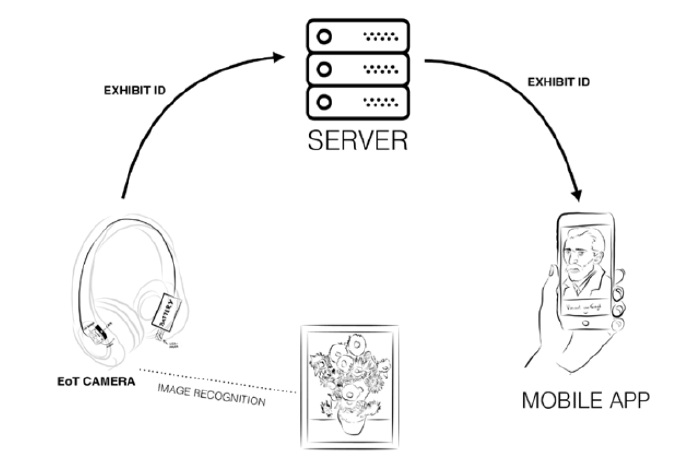
Figure 6. Multimedia museum guide